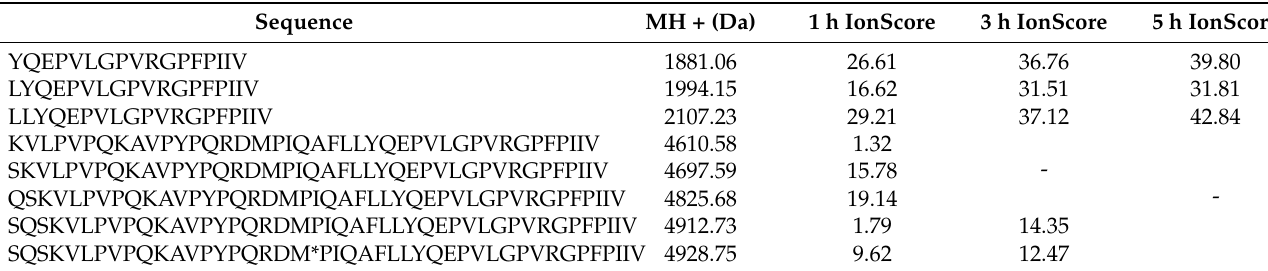
Table 2. Bitter peptide of